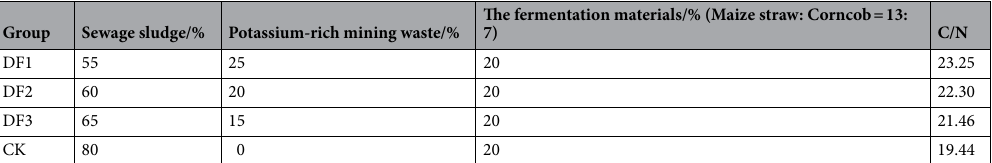
Table 1. The material ratio and C/N of each experimental group. (n =